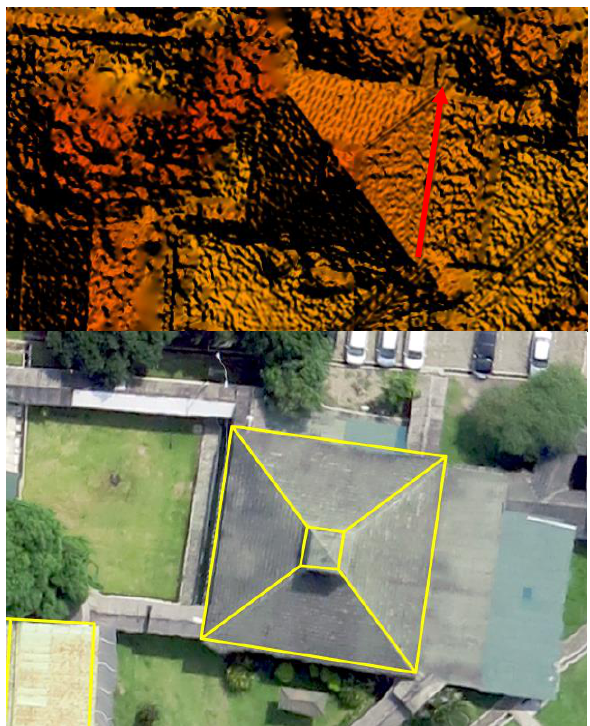
Figure 6. Mosque building object : DEM (upper), building outlines (lower)